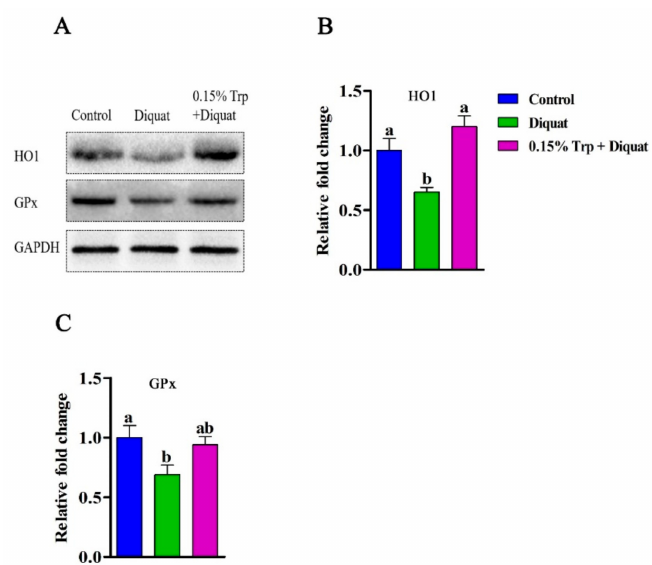
Figure 6. E ff ects of dietary tryptophan supplementation on protein expression of antioxidant enzymes in piglets challenged with diquat. ( A ) Representative blots of HO1, GPx, and GAPDH in the jejunal mucosa of piglets; ( B ) HO1, heme oxygenase 1; ( C ) GPx, glutathione peroxidase. Data are means ± standard error; n = 8 for each group. Mean values sharing di ff erent superscripts within the same row di ff er significantly ( p < 0.05). Control, piglets fed the basal diet without diquat injection; diquat, piglets fed the basal diet and challenged with diquat; 0.15% Trp + diquat, piglets fed the 0.15% supplemented diet and treated with diquat.